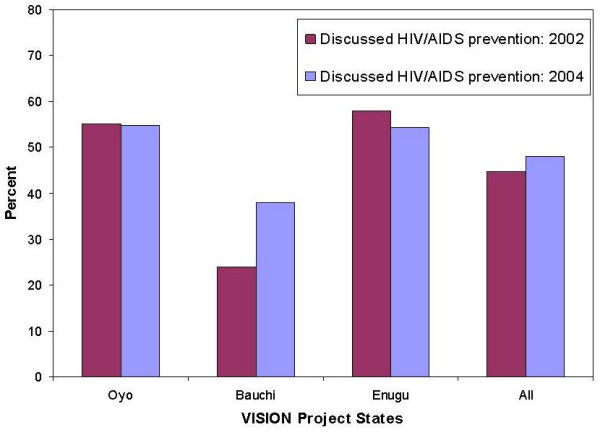
VISION outcome indicator in relation to 2002 baseline data: Discussed HIV/AIDS prevention Figure legend text – Percentage of respondents that have discussed ways to prevent getting HIV/AIDS with partner: 2002 baseline and 2004 follow-up data. Aggregated estimates were calculated using weighted data